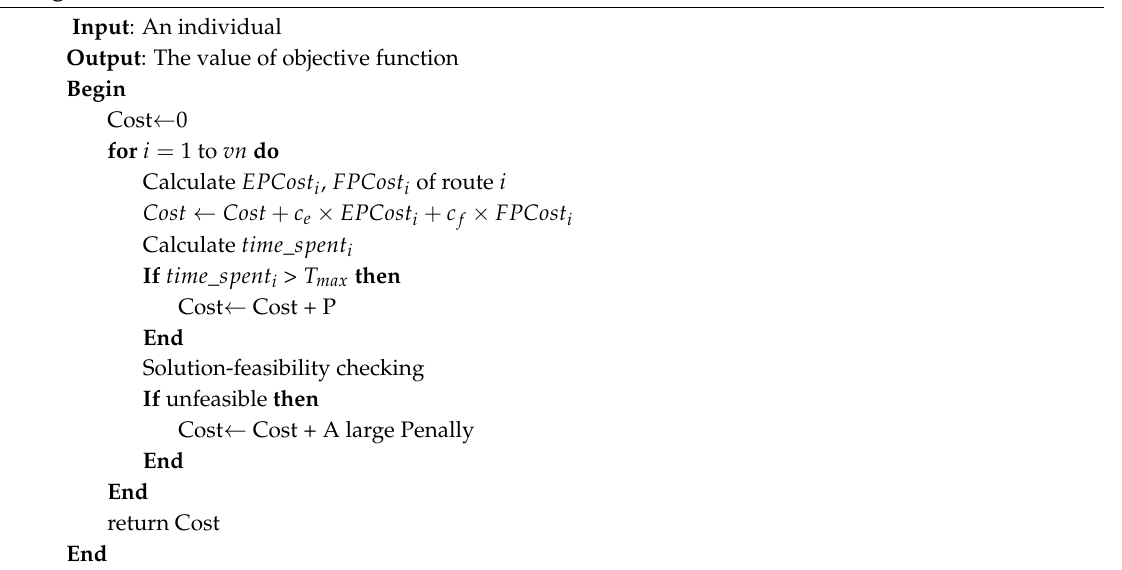
Algorithm 2: Evaluation of the